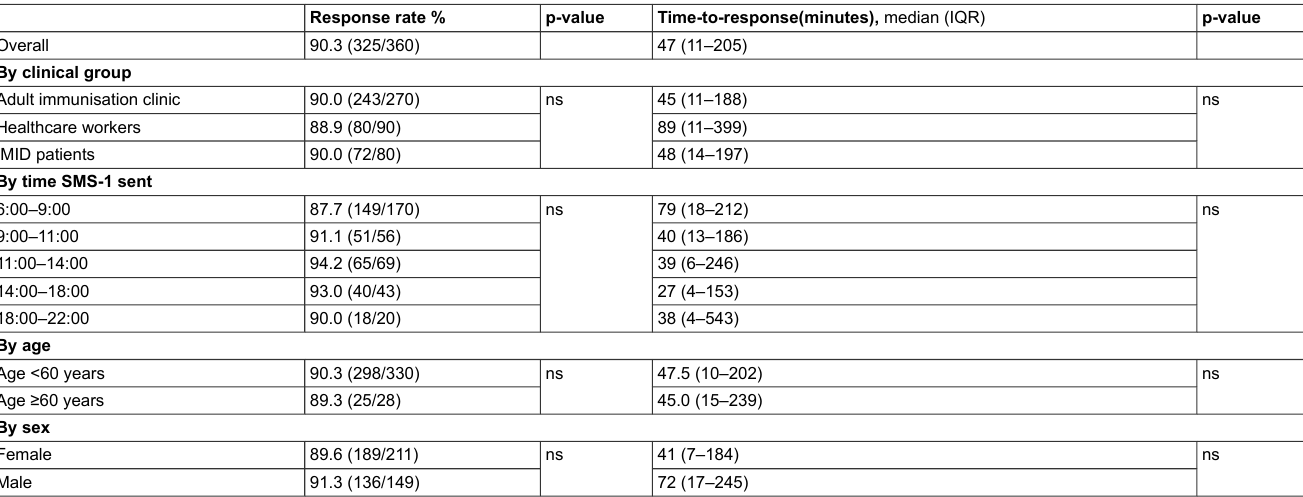
Table 2: SMS response rates and time-to-response across different